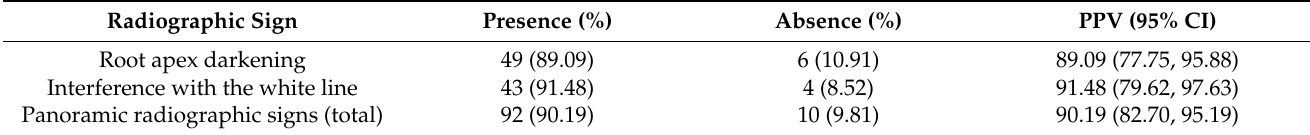
Table 2. Frequency distribution of panoramic radiographic signs and their PPV in comparison with the gold standard (CBCT) Radiographic Sign Presence (%) PPV (95% CI) Root apex darkening Interference with the white line Panoramic radiographic signs